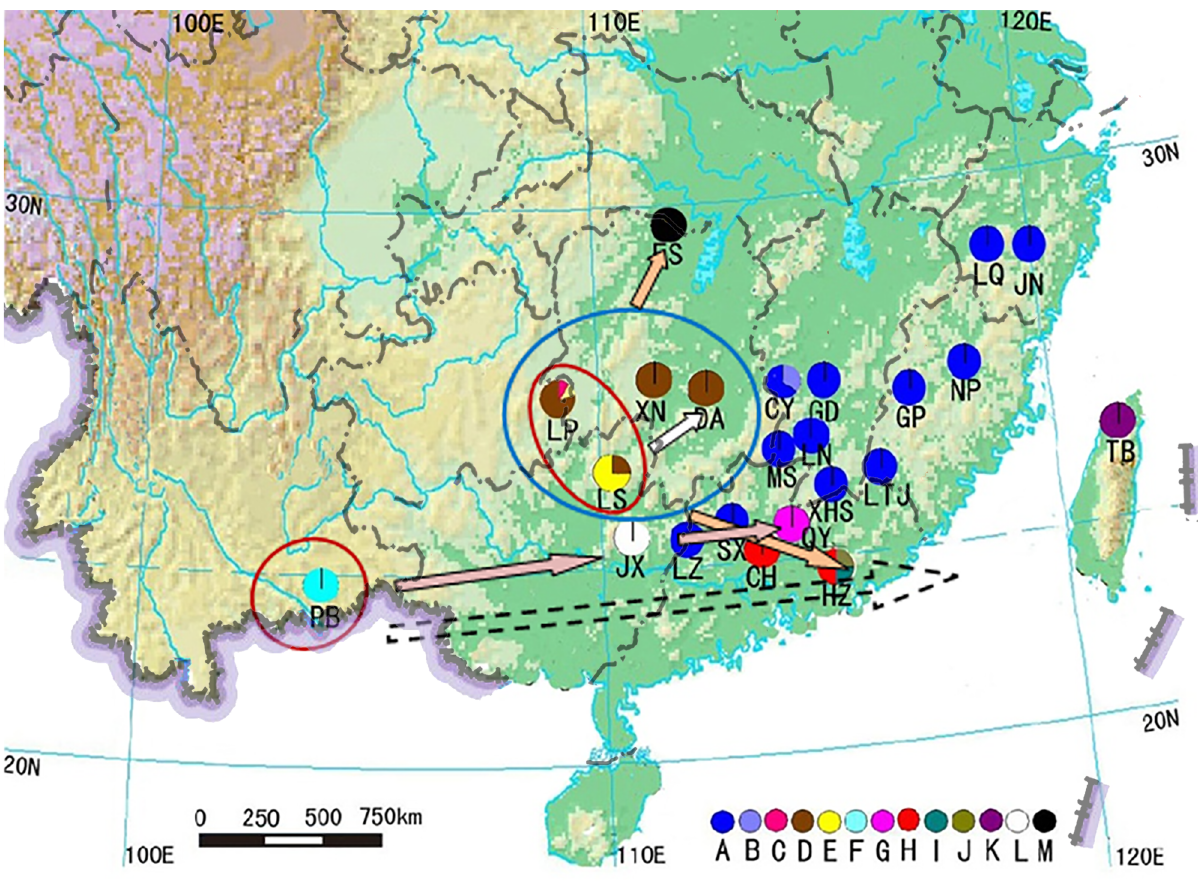
Fig 4. Possible migration and expansion routes of Bretschneidera sinensis in China. Letters belowthe colorfulcircles in the map stand for the population names; different colorful circles are to distinguish the haplotypes (see Legend);Three larger circles stands for refugia; arrows